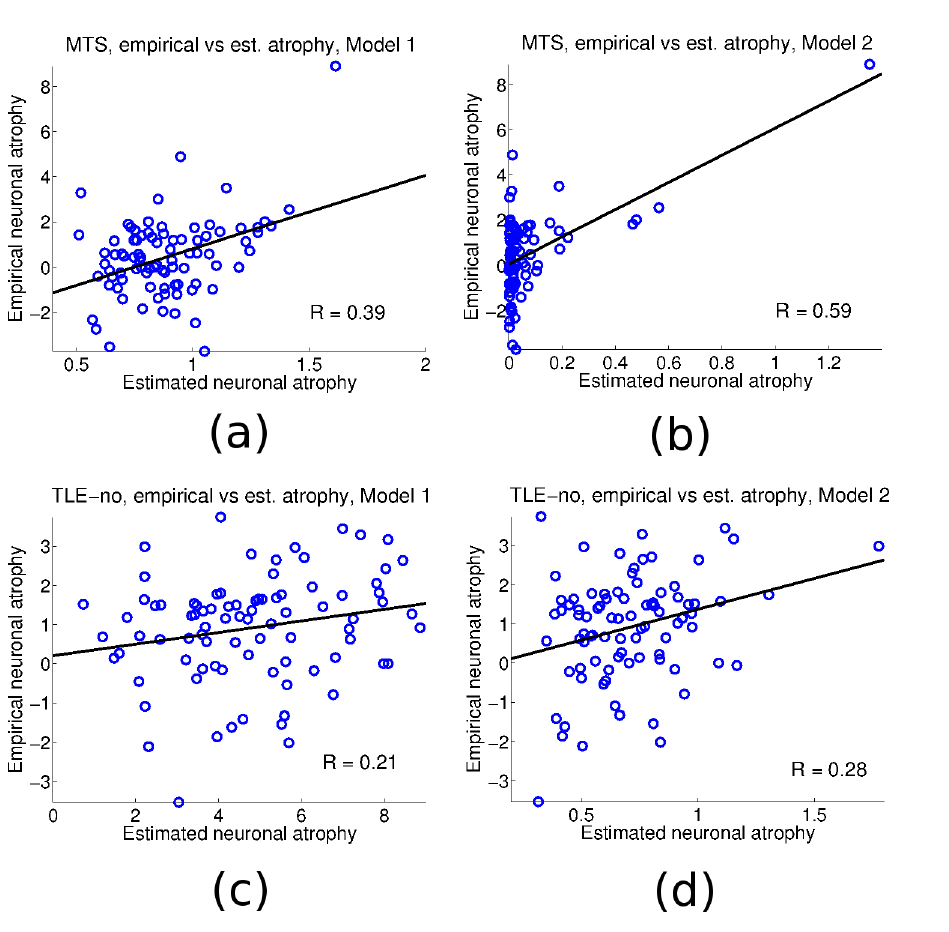
Fig 4. Scatter plots for each model and epilepsy type of the measured neuronal atrophy vs. the neuronal atrophy as estimated by the two models. Empirical vs. estimated neuronal atrophy for the case of TLE-MTS; Model 1 (a), and Model 2 (b); and measured vs. estimated neuronal atrophy for the case of TLE-no; Model 1 (c), and Model 2 (d). For both types of epilepsy, Model 2 outperforms Model